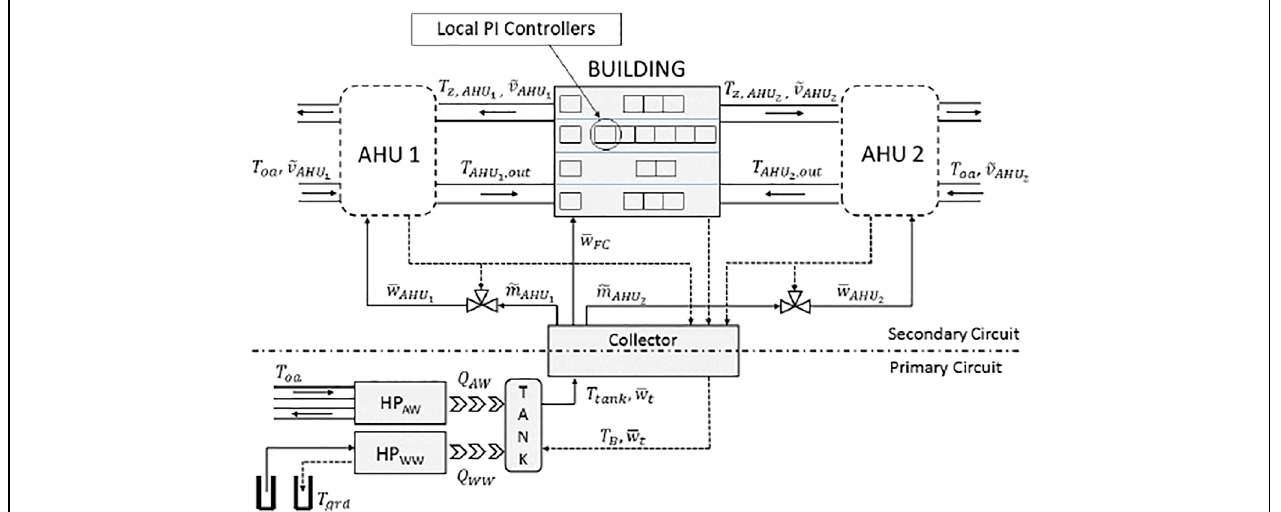
FIGURE 7 | Overall flow diagram of building and HVAC